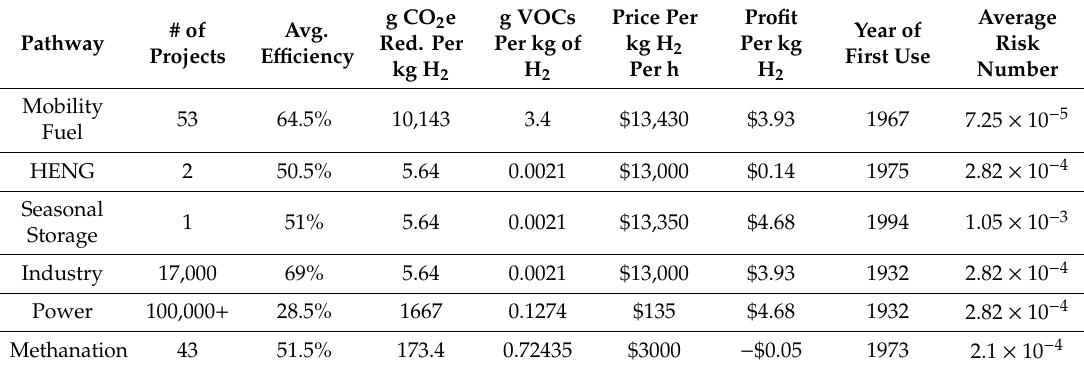
Table 14. Raw Data for power-to-gas Pathways.